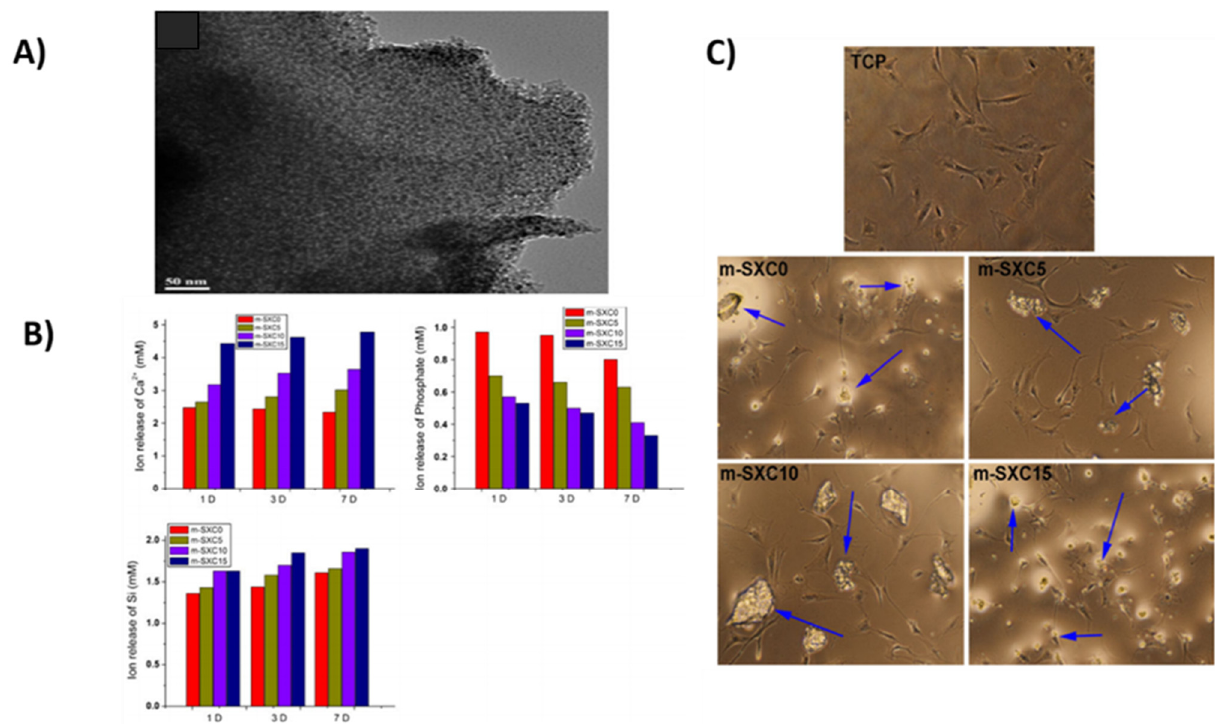
Figure 5. ( A ) TEM micrograph of Ca-doped xerogel surface. Bar equals 50 nm. ( B ) Change in ion concentration of Ca, Si, and P after m-SXCs immersed in SBF for1, 3, and 7 days. Results shown are mean values from three parallel experiments. ( C ) Light micrograph for osteoblast cells cultured with m-SXCs for 24 h, with 0, 5, 10, and 15%, named m-SXC0, m-SXC5, m-SXC10, and m-SXC15, respectively, and tissue culture plastic. The arrows show silica particles. Adapted from [74]. Reproduced with permission from Springer.